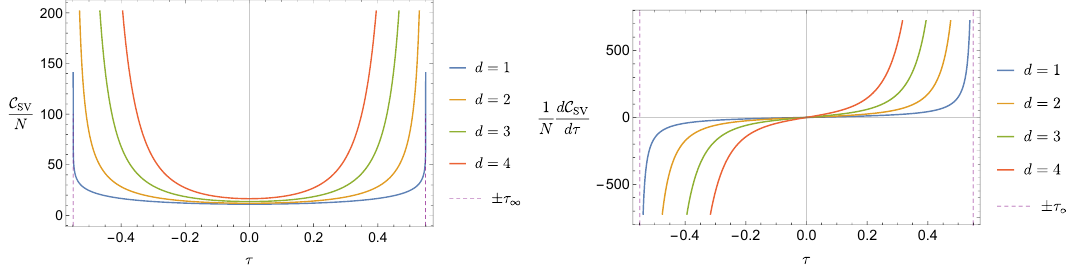
Figure 5 . The time evolution of holographic complexity and its growth rate from CV2.0 with ρ = 1 / 2